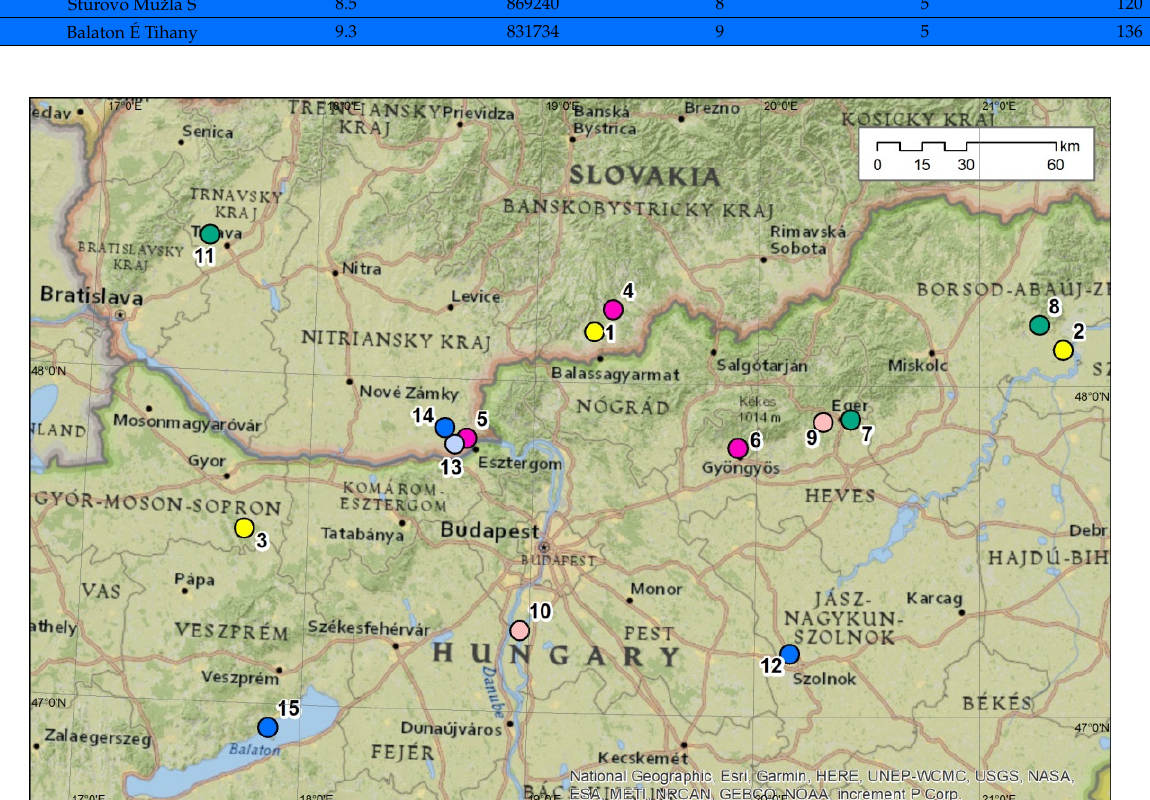
Figure 4. Localisation of selected sensors from Table 4; the colour distinction of the dots identifying sensor location is the same as in Table 3.